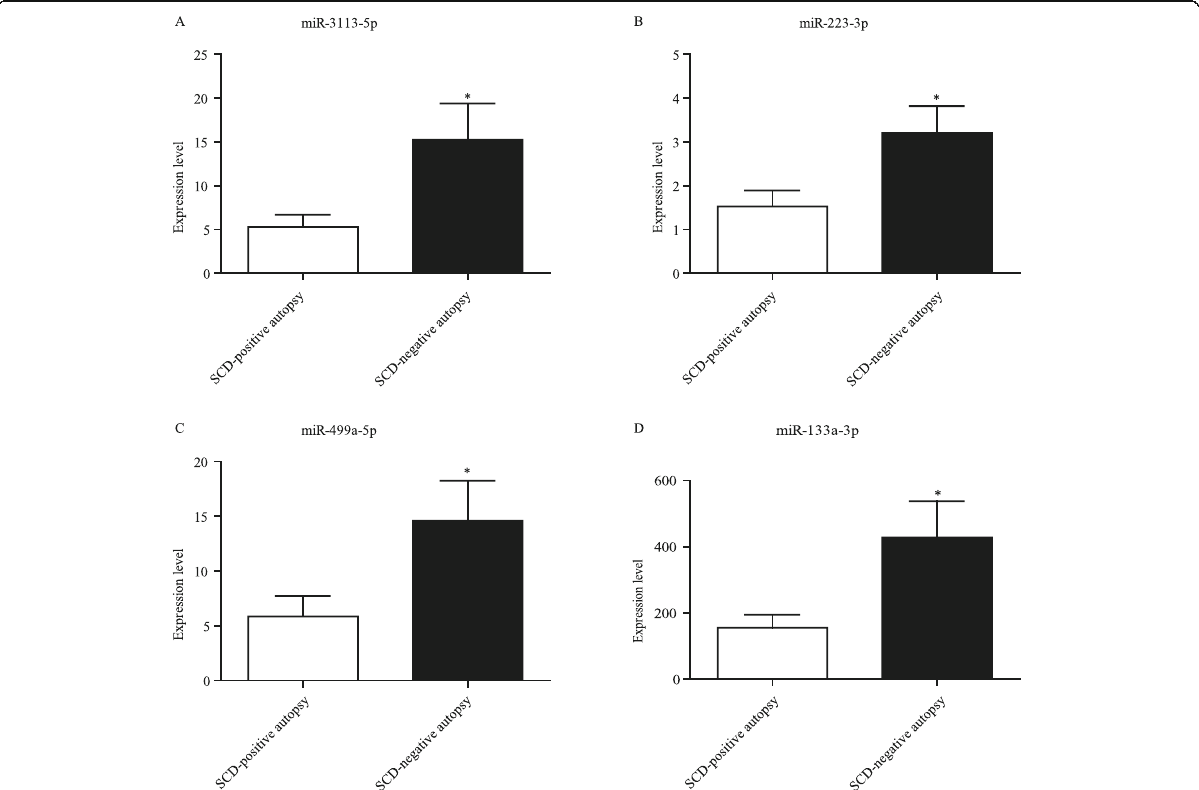
Fig. 5 The relative expression level of the four miRNAs between SCD-positive autopsy ( n = 18) and SCD-negative autopsy groups ( n = 16). miR- 3113-5p ( A ), miR-223-3p ( B ), miR-499a-5p ( C ), and miR-133a-3p ( D ) were upregulated in SCD-negative autopsy group as compared to the SCD- positive autopsy. Results were normalized to U6 gene, * p < 0.05 versus SCD-positive